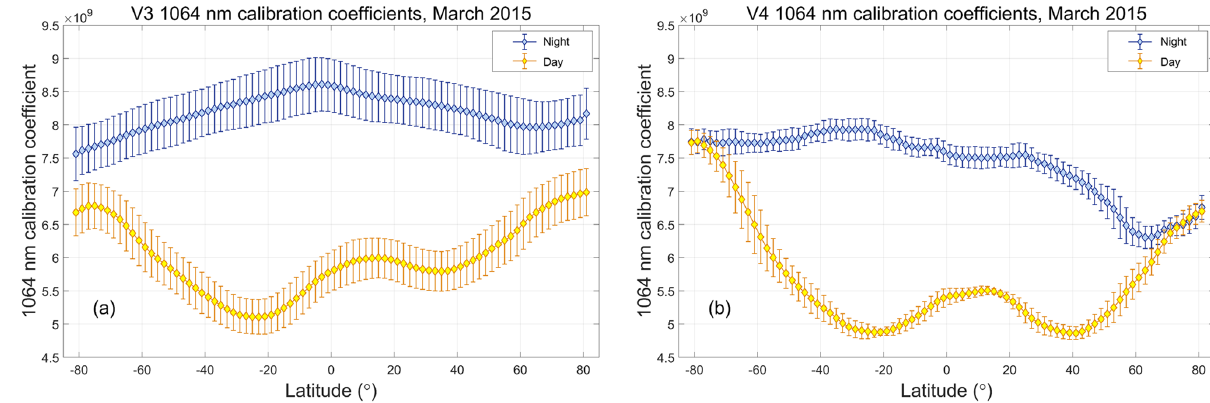
Figure 20. Zonal mean 1064nm calibration coefficients for March 2015; panel (a) shows V3 calibration coefficients (units: km − 3 srJ − 1 ), while panel (b) shows the V4 coefficients (units: km − 3 srJ − 1 count). In both panels, nighttime values are shown in blue and daytime values in yellow. Error bars represent 1 standard deviation about the